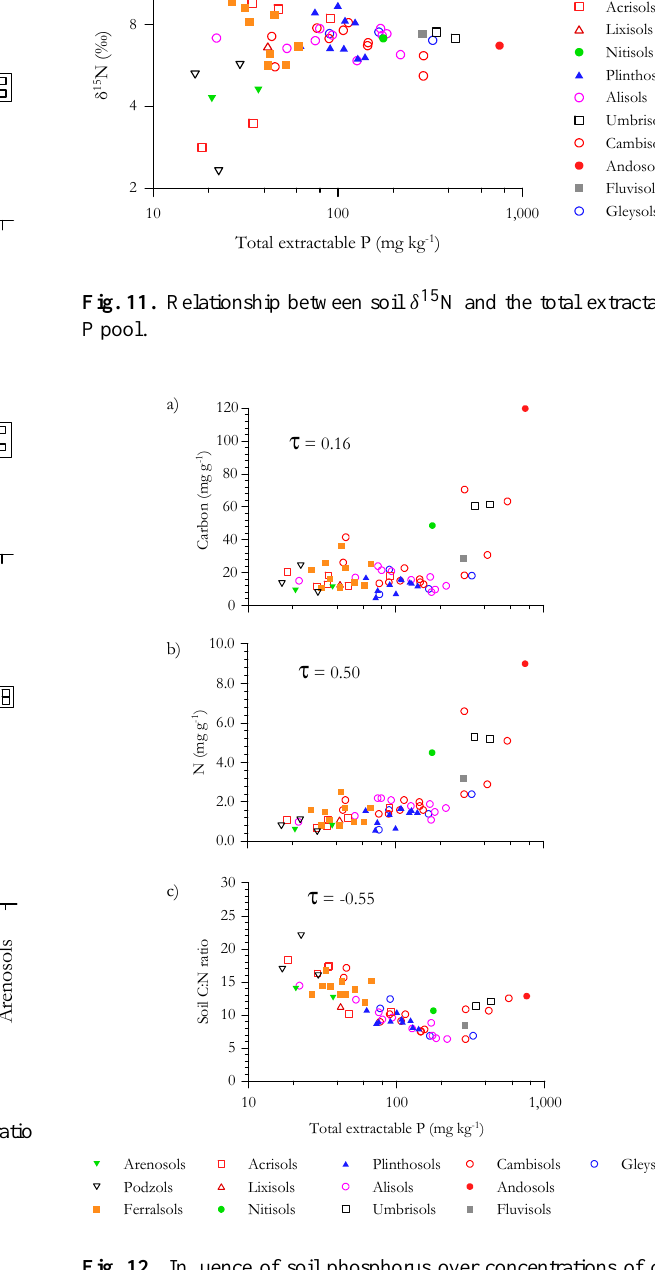
Fig. 12. Influence of soil phosphorus over concentrations of car- Fig. 12 bon (a) , nitrogen (b) and C:N ratio (c) . Values of Kendall’s τ rank correlation coefficient are also